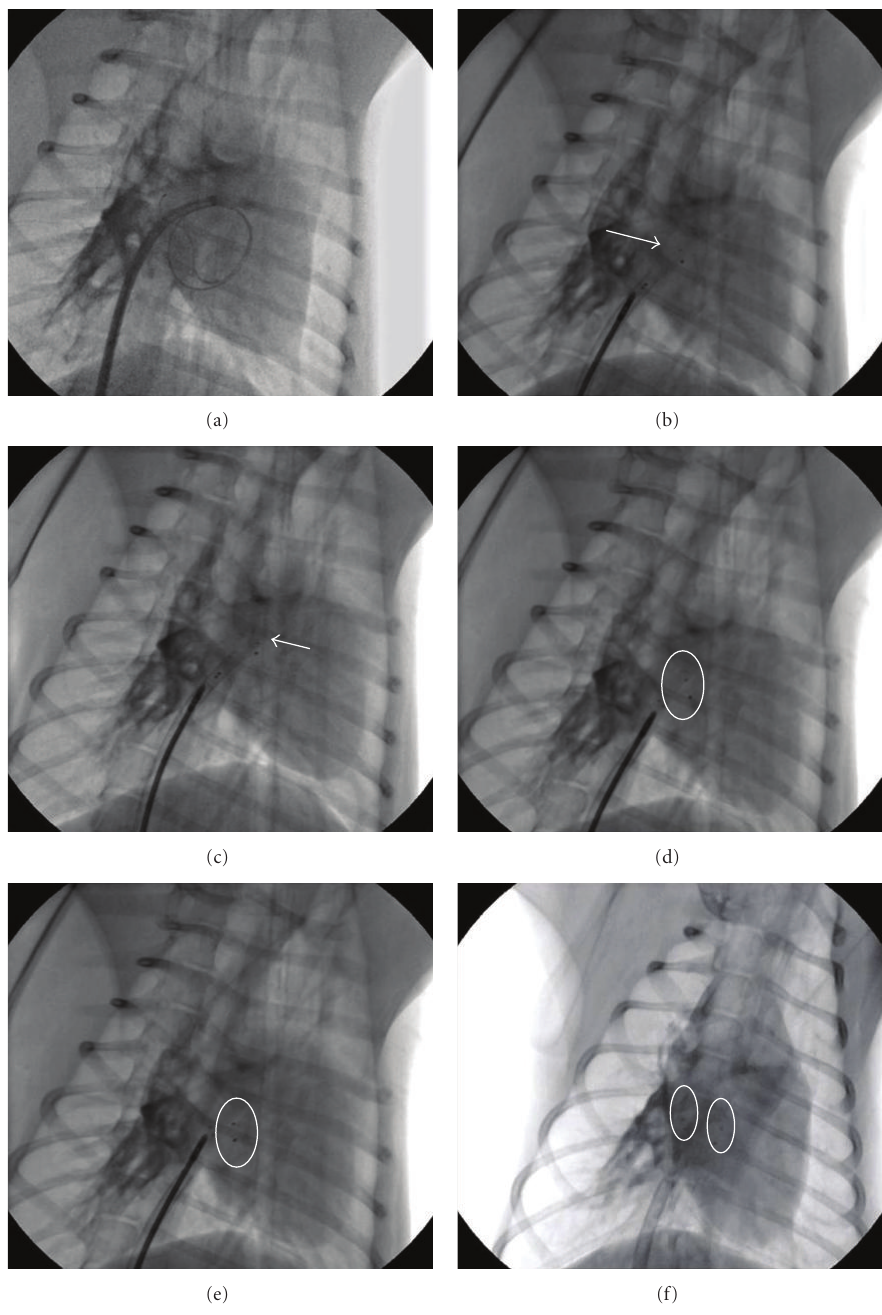
Figure 2: Transcatheter placement of biodegradable ASD occluder (a) retains the guide wire after the model was created; (b) the occluder (indicated by the white arrow) passes through a sheath, and tantalum marker particles can be seen in the front of occluder; (c) unsheathed the left atrial side of occluder (indicated by the white arrow); (d) the release of the left atrial side of occluder, tantalum particles were unsheathed and separated; (e) the release of the right atrial side of occluder, separation of tantalum particles can be seen (see the white oval); (f) after the occluder release, tantalum markers indicate that both of the two discs were well opened (two small white